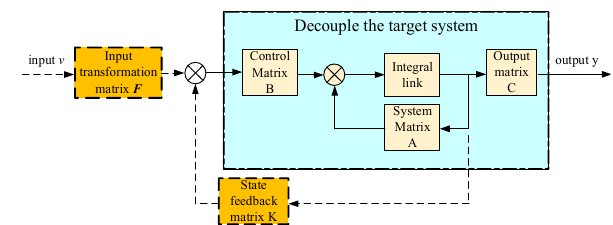
Figure A1. DFIG control model decoupling diagram.